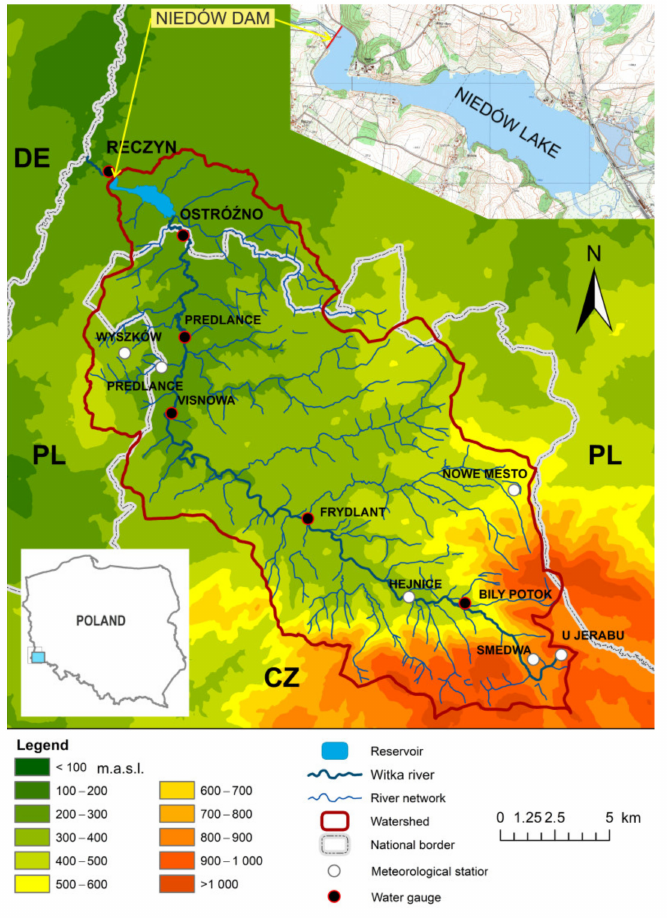
Figure 1. The catchment area of the Witka